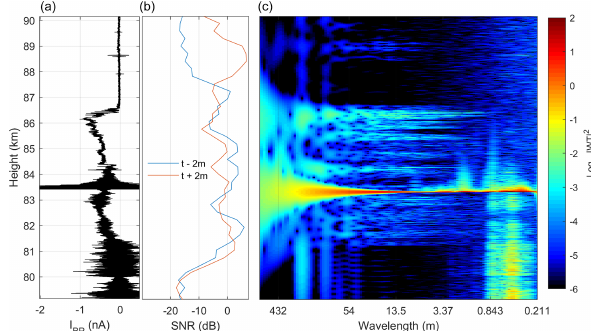
Figure 15. Comparison of DUSTY bottom plate current (a) , MAARSY 53.5 MHZ radar SNR along the rocket trajectory (b) , and PSD from wavelet transform (c) – for the MXD-1 launch the 30 June 2016. Conversion from frequency to spatial scales is carried out as in Fig. 13, by using the mean rocket velocity throughout the dust cloud. Radar data courtesy of Ralph Latteck, IAP Kühlungs-